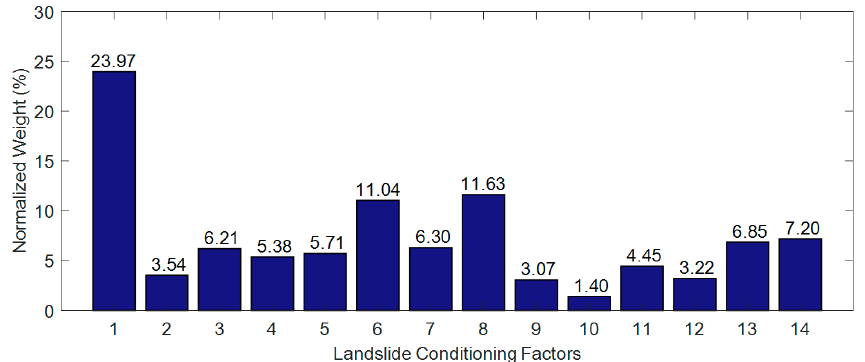
Figure 3. Variable analysis with the ReliefF method: (1)—Slope; (2)—Slope length; (3)—Aspect; (4)—Curvature; (5)—Elevation; (6)—TWI; (7)—SPI; (8)—STI; (9)—Valley depth; (10)—Topo-shape; (11)—Distance to faults; (12)—Land use, (13)—Soil type; and (14)—Lithology).